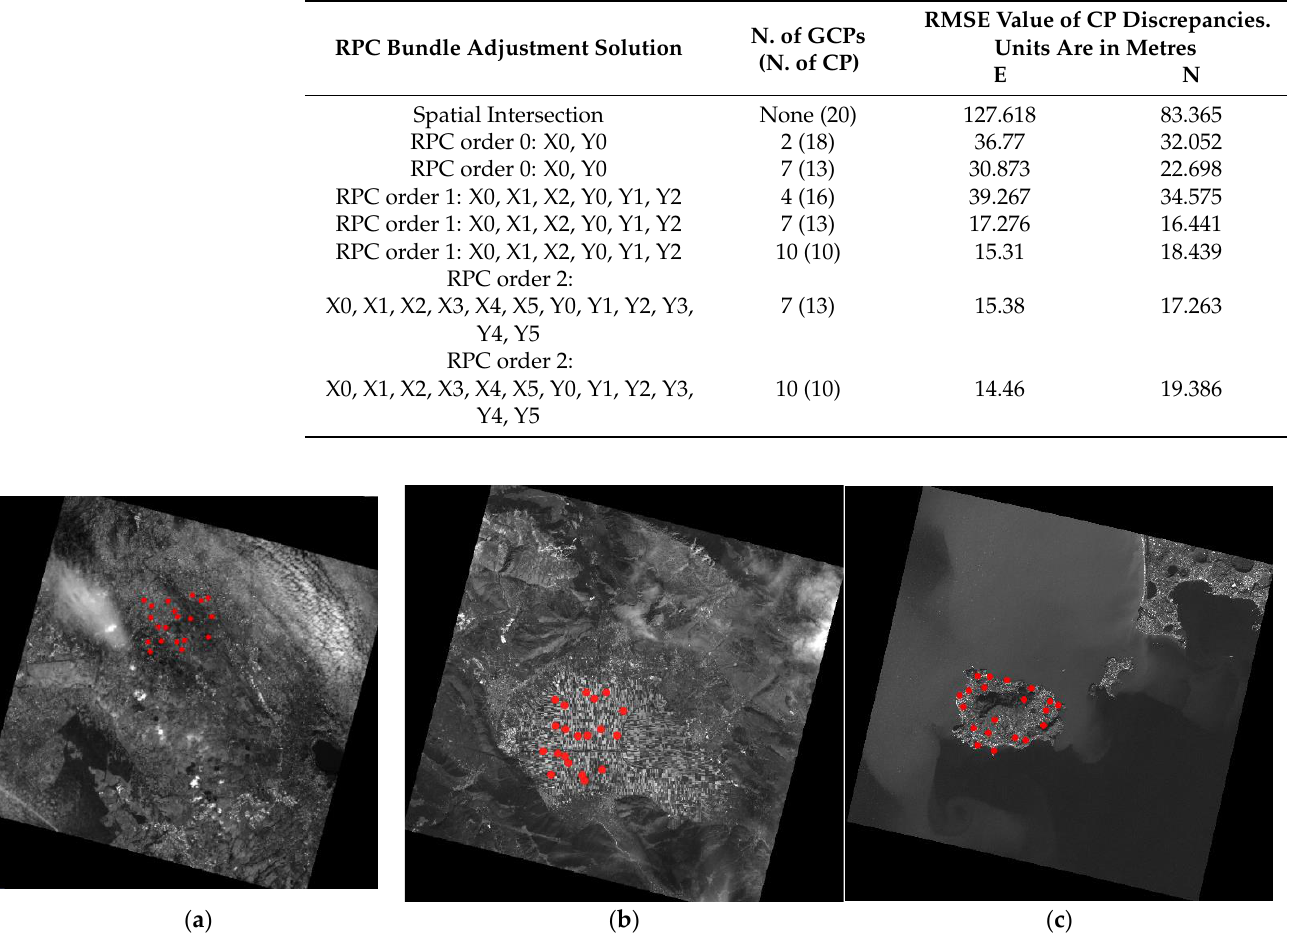
Table 7. Results of RPC bundle adjustment with bias compensation for Fucino plain.